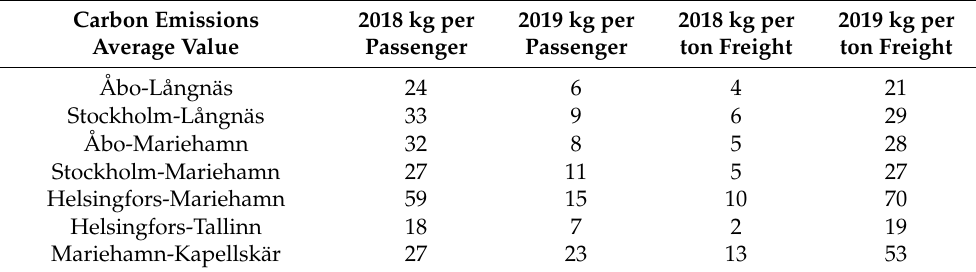
Table 2. Carbon emissions on Viking Lines routes during 2018 and 2019, based on public data from